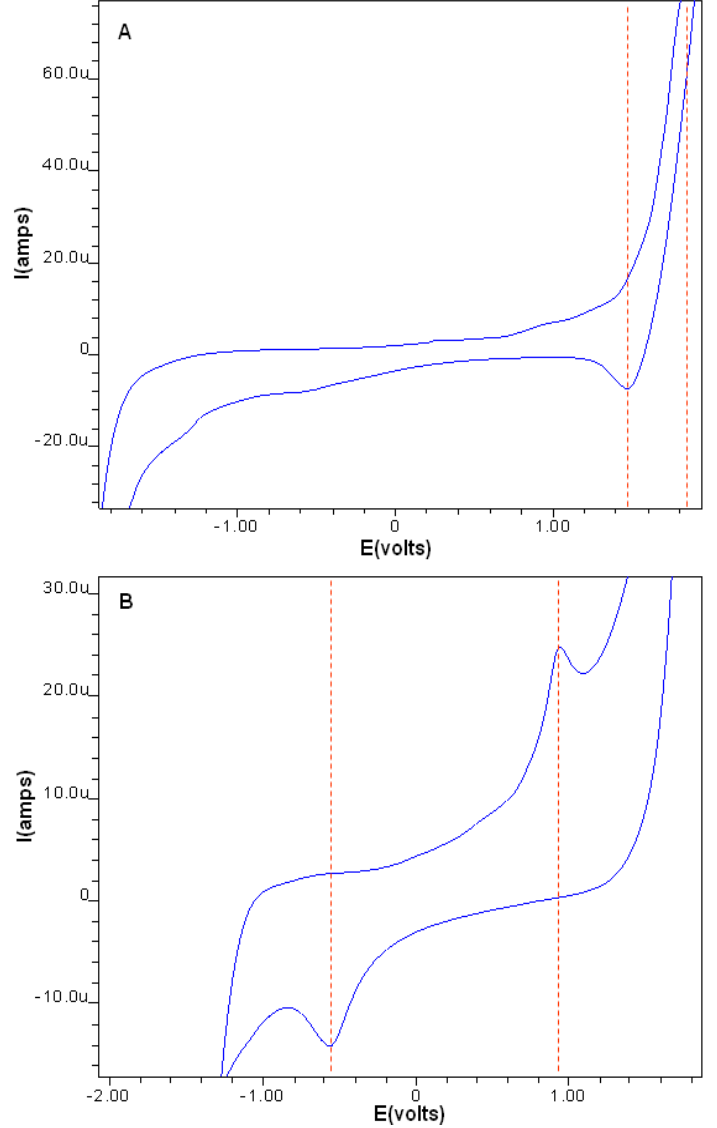
Figure 2. Cyclic voltammograms of carnosine ( A ) and the Ru-carnosine complex ( B